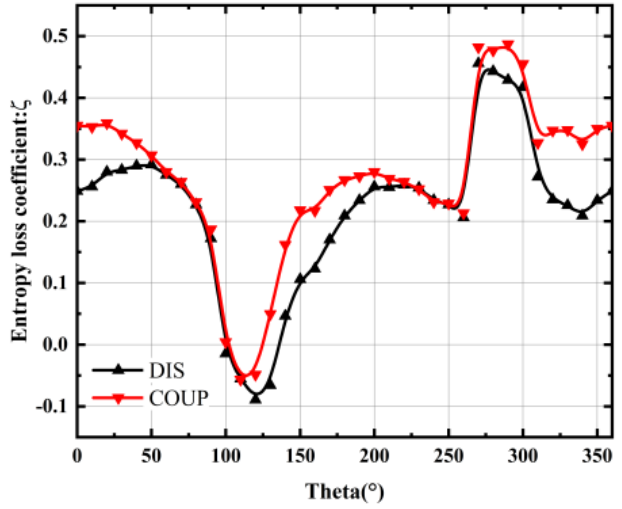
Figure 12. Comparison of circumferential distribution of entropy loss coefficient at 10% spanwise.